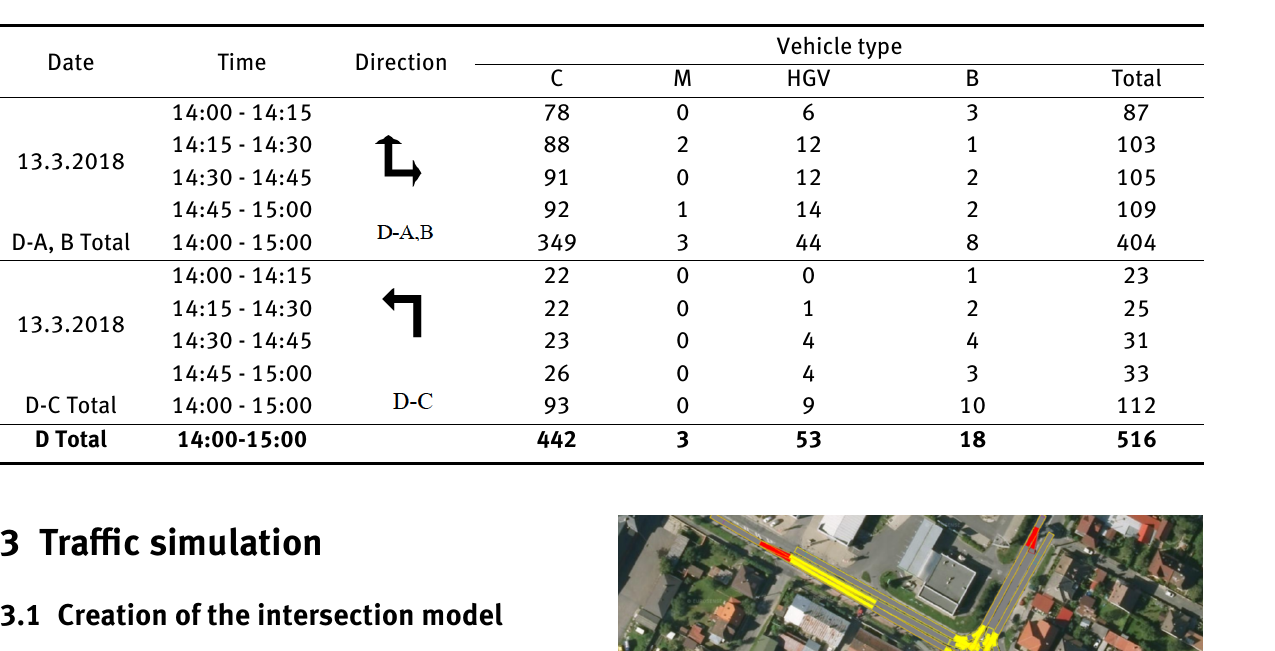
Table 4: Traflc intensity - results of traflc survey 2nd day [30]